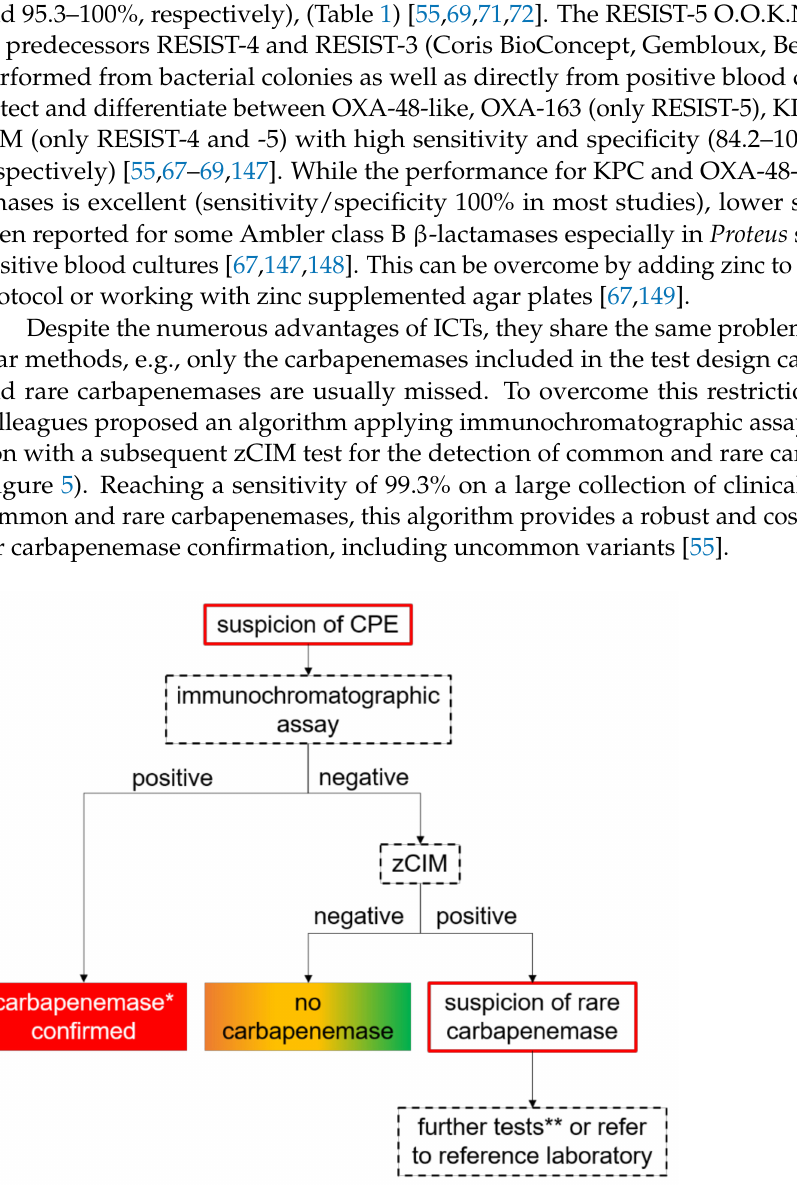
Figure 5. Algorithm for the detection of carbapenemases in routine laboratory as proposed by Baeza et al. * OXA-48-like KPC, VIM, NDM, (IMP). ** Multiplex PCR targeting rare carba-penemases (e.g., IMI, GES, etc.), whole genome sequencing, other tests [61]. Boattini and colleagues proposed a fast-track workflow for Enterobacterales from positive blood cultures combining the NG-Test CTX-M MULTI and the NG-Test